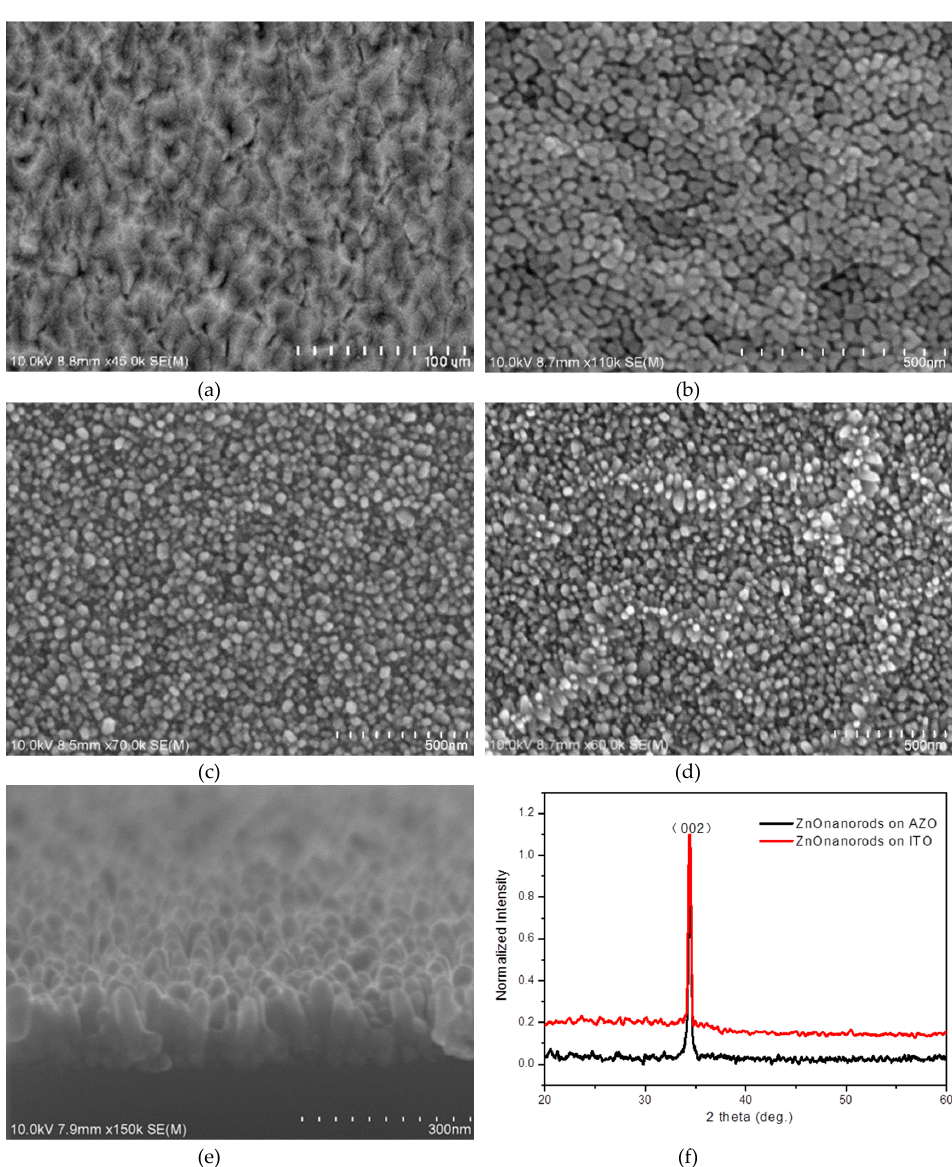
Figure 3. Top-view SEM of AZO surface ( a ), ZnO seed layer on AZO ( b ) and ZnO nanorods on AZO ( c ) and ITO ( d ), the cross-view SEM of ZnO nanorods on AZO ( e ), and XRD of ZnO nanorods ( f ).